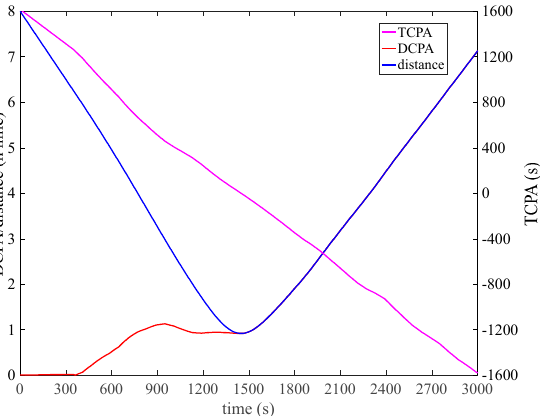
Figure 16. The curve of ship encounter parameters varies with time in crossing situation.